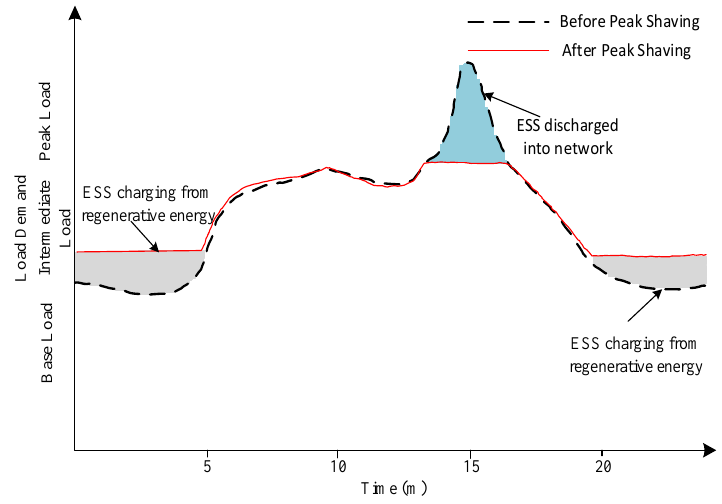
Figure 15. ESS application for peak shaving and load-levelling.